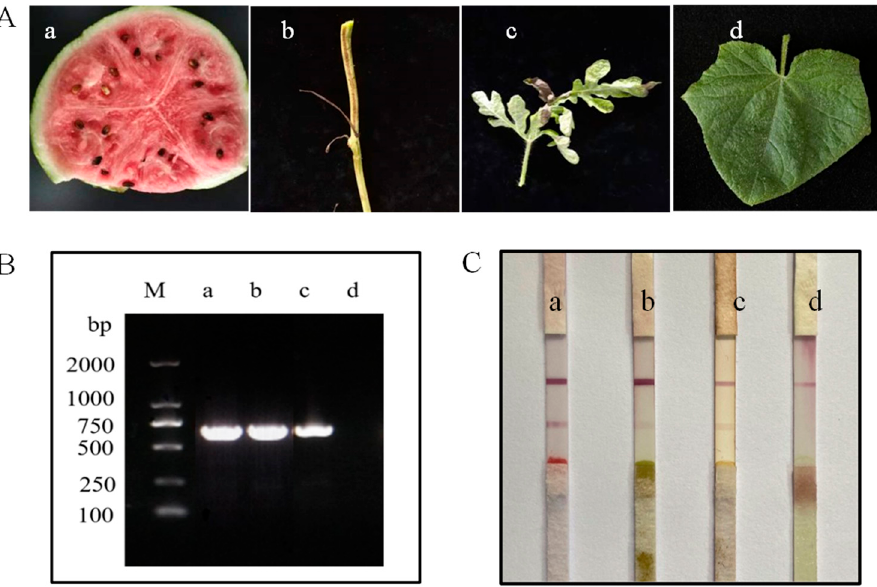
Figure 6. ( A ) Field sample. a: Field-diseased watermelon; b: Field-diseased stem; c: Field-diseased leaf; d: Field-healthy leaves. ( B ) PCR detection of fi eld samples. ( C ) Detection using the ICS test.